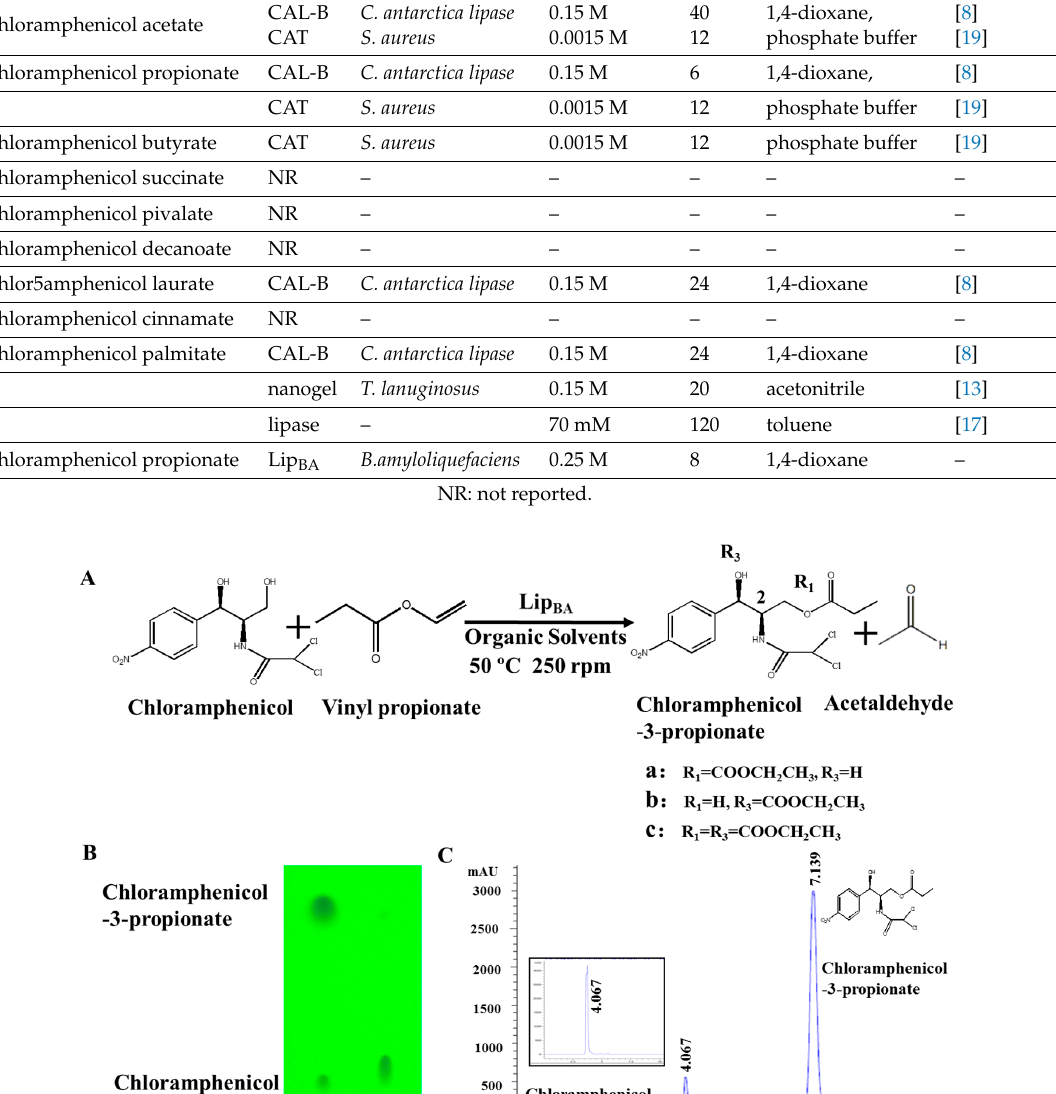
Table 1. Recent experimental studies in chloramphenicol esters synthesis by enzymatic catalysis. Chloramphenicol Esters